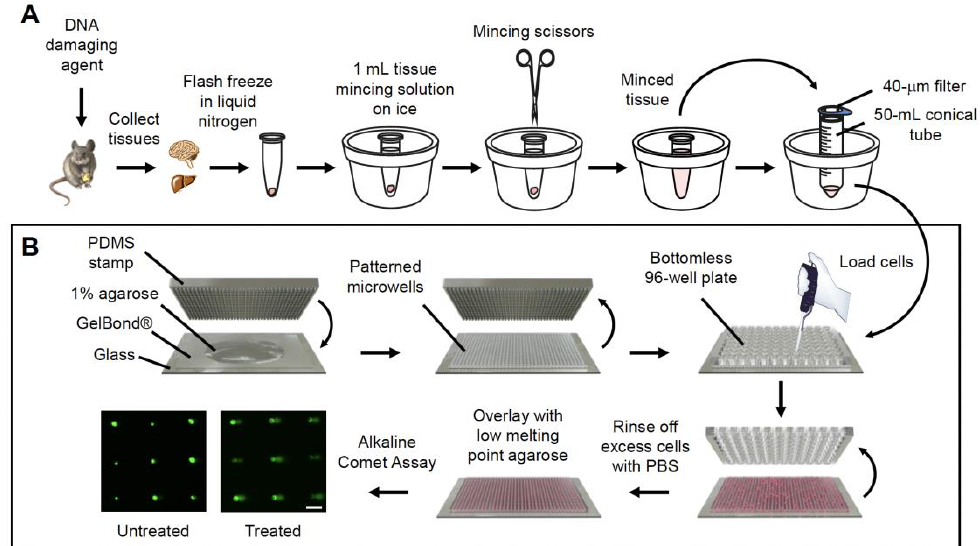
Figure 1. Schematic for the in vivo CometChip assay. ( A ) Mice are exposed to a DNA damaging agent, and tissues from various organs are collected and immediately flash frozen in liquid nitrogen. The tissues are transferred to − 80 ◦ C for long term storage until ready for the CometChip assay. To make cell suspensions, tissues are immersed in 0.5–1.0 mL of cold tissue mincing solution and gently minced on ice and cell suspensions are filtered through a 40- µ m filter to remove debris. ( B ) To make the CometChip, 1% normal melting point agarose in PBS is prepared. A polydimethylsiloxane (PDMS) stamp with an array of micropegs is pressed into molten agarose solution on top of the hydrophilic side of a sheet of Gelbond film. The agarose is allowed to gelate and the PDMS stamp is removed to reveal an array of microwells. A bottomless 96-well plate is pressed on top of the agarose chip to form 96-macrowells. Filtered cell suspensions are loaded onto the CometChip and excess cells are rinsed with PBS. The loaded cells are capped with 1% low melting point agarose and the alkaline comet assay is performed as described in the Materials and Methods. Scale bar = 100 µ m. Cells from all the tissues were successfully loaded onto the CometChip (Figure 2A).